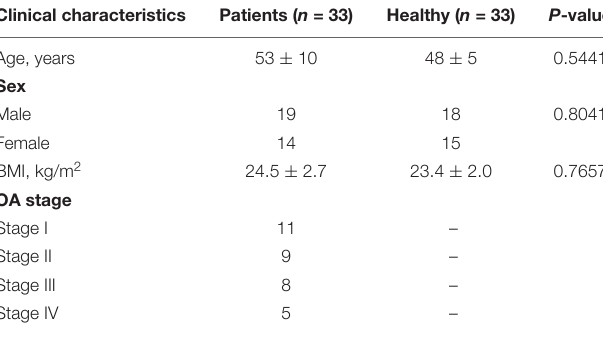
TABLE 1 | Clinical characteristics of osteoarthritis (OA) patients and healthy controls. Clinical